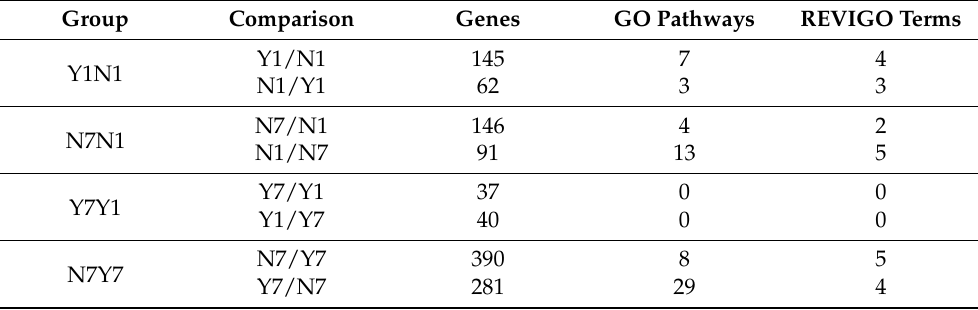
Table 2. Group comparison information regarding significantly expressed genes, Gene Ontol- ogy (GO) pathways, and REVIGO terms. Gene lists, GO pathways, and REVIGO terms were generated from transcripts identified by any pipeline. Specific information can be found in Supplementary Tables S1–S4. Group N1Y1 represents comparisons between the non-bloodfed/non- dehydrated and the bloodfed/non-dehydrated groups; N7N1, non-bloodfed/dehydrated and non- bloodfed/non-dehydrated groups; Y7Y1, bloodfed/dehydrated and bloodfed/non-dehydrated groups; N7Y7, non-bloodfed/dehydrated and bloodfed/dehydrated groups. Group Comparison Genes GO Pathways REVIGO Terms Y1/N1 Y1N1